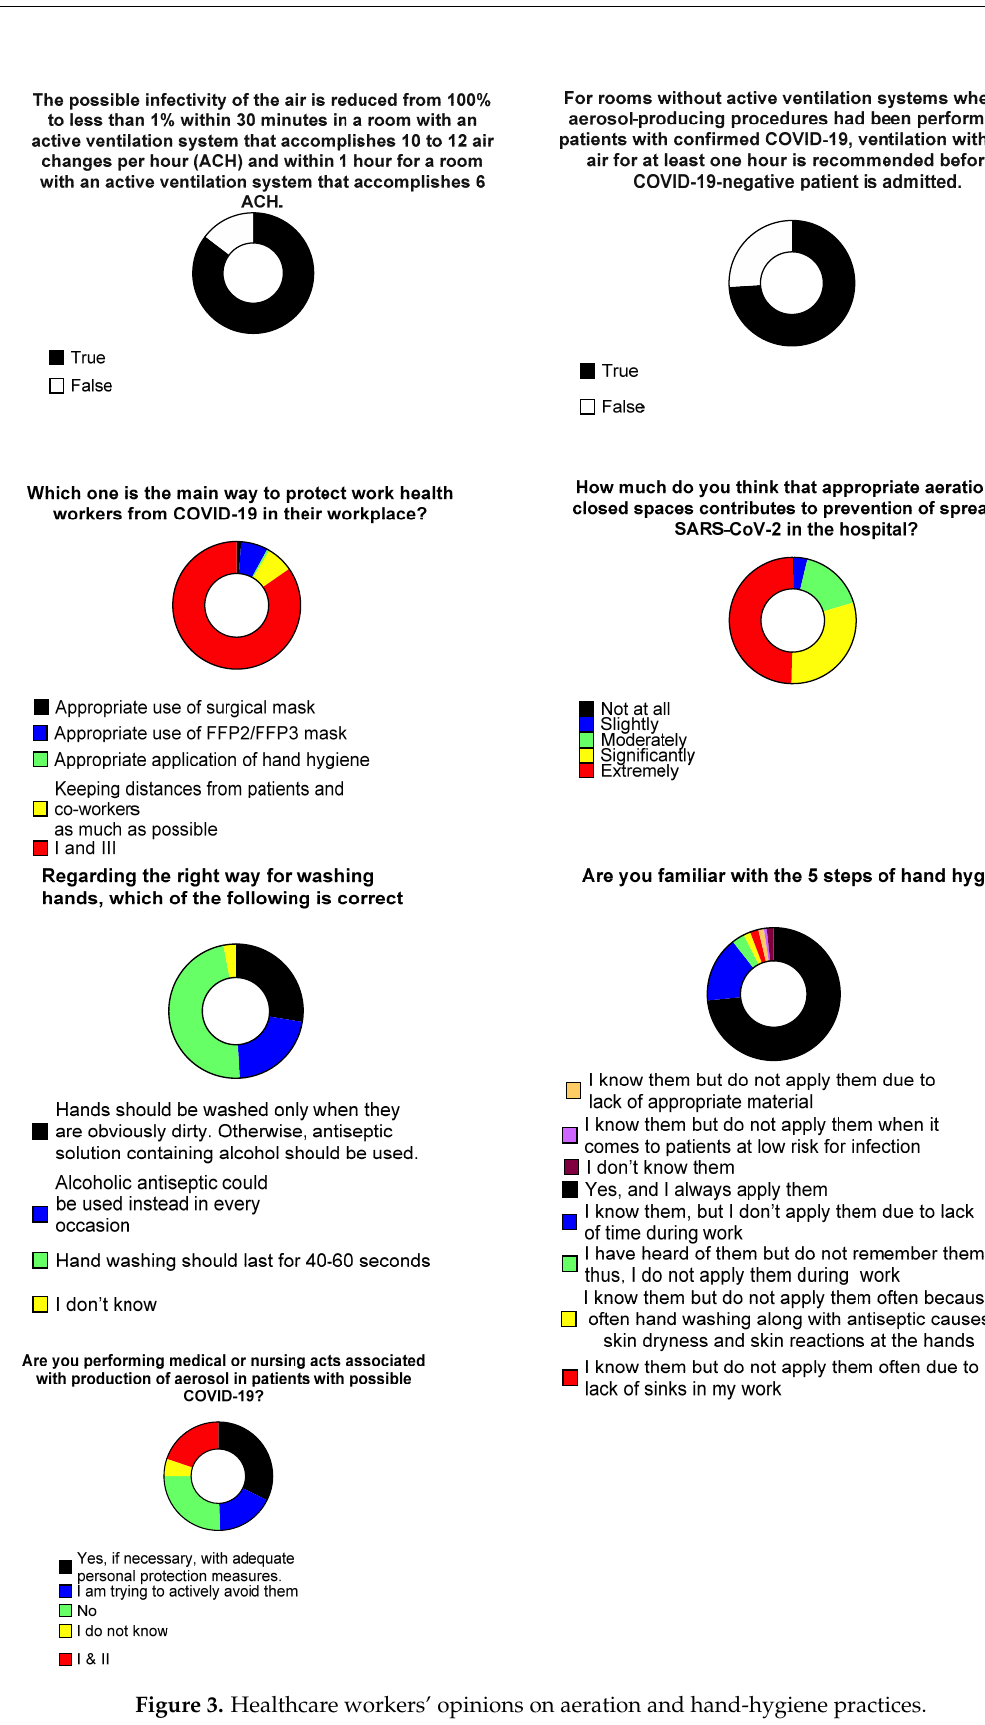
Figure 3. Healthcare workers’ opinions on aeration and hand-hygiene practices.